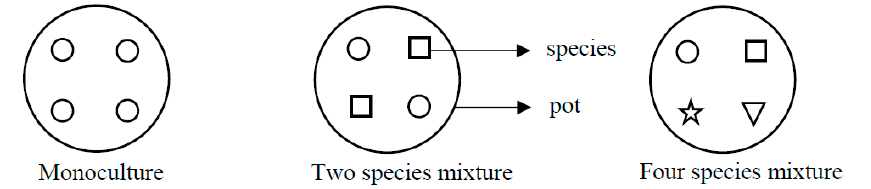
Figure 1. The planting pattern of the pot experiment. Different symbols indicate different species.